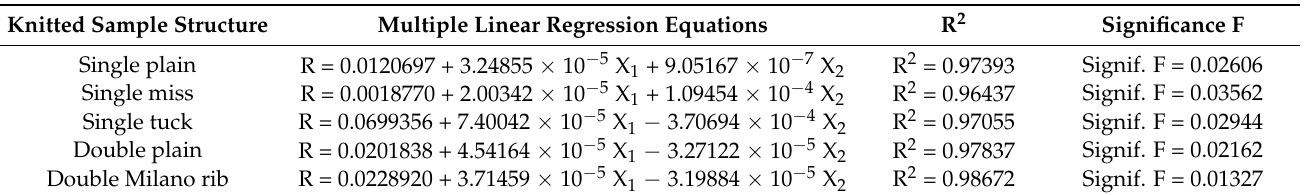
Table 12. Relationship between heat resistance (R), yarn hairiness (X 1 ) and mass per unit area (X 2 ) for different knitted